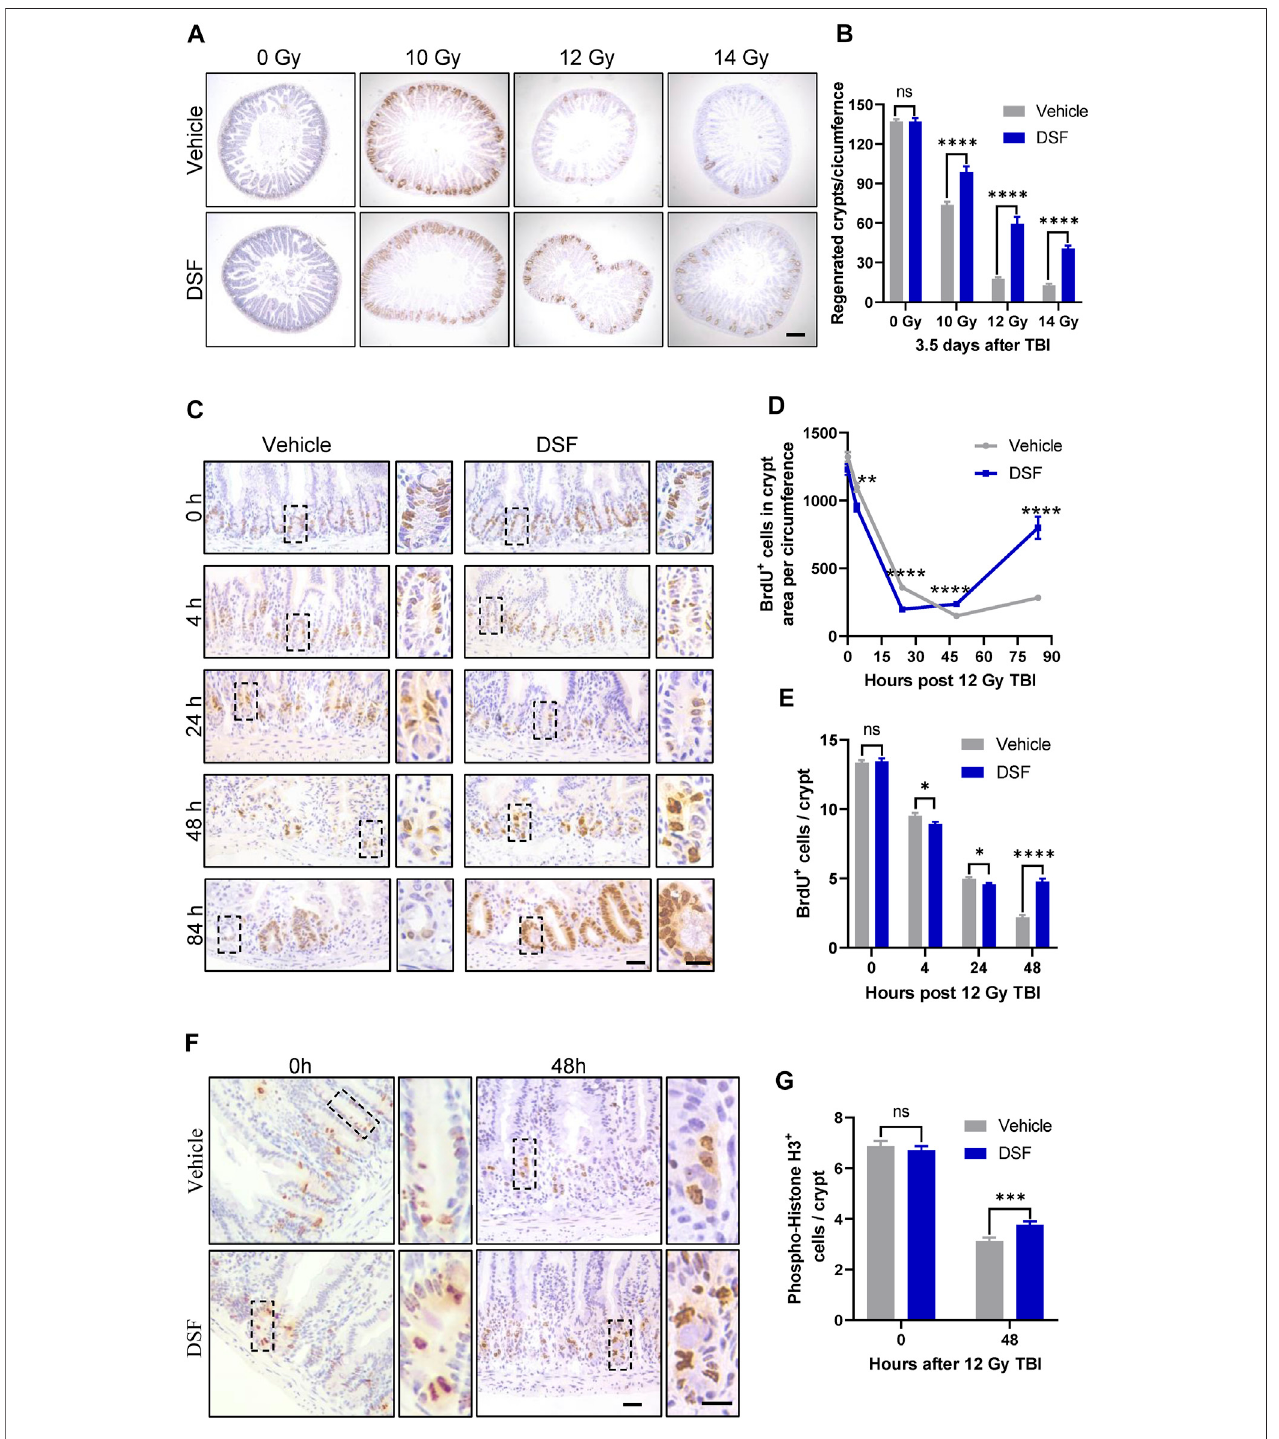
FIGURE 2 | DSF enhances crypt regeneration after irradiation. Mice were intraperitoneal injected with 100 mg/kg DSF or vehicle 1 h prior to 12 Gy TBI. (A) RepresentativeimagesofBrdUIHC ofintestinal sections at3.5 daysafter 10,12and14 GyTBI.Scalebar =200 μ m. (B) Quantitativeanalysisofregeneratedcryptsper circumference in (A) . (C) Representative images of BrdU IHC intestinal sections at the indicated times after 12 Gy TBI. Scale bar = 25 μ m (left) and 10 μ m (right). (D) Quantitative analysis of BrdU + cells in crypts area per circumferences in (C) . (E) Quantitative analysis of BrdU + cells per crypts in (C) . (F) Representative images of phospho-histoneH3 + IHCincryptsat48 hafter12 GyTBI.Scalebar=25 μ m(left)and10 μ m(right). (G) Quantitativeanalysisofphospho-histoneH3 + cellspercryptsin (F) . Values are means ± SEM; n = 3-4 mice in each group. * p < 0.05, ** p < 0.01 and **** p < 0.0001, vehicle versus DSF treatment, by unpaired, two-tailed Student ’ s t-test. BrdU,5-Bromo-2 ′ -deoxyuridine; IHC, immunohistochemistry.